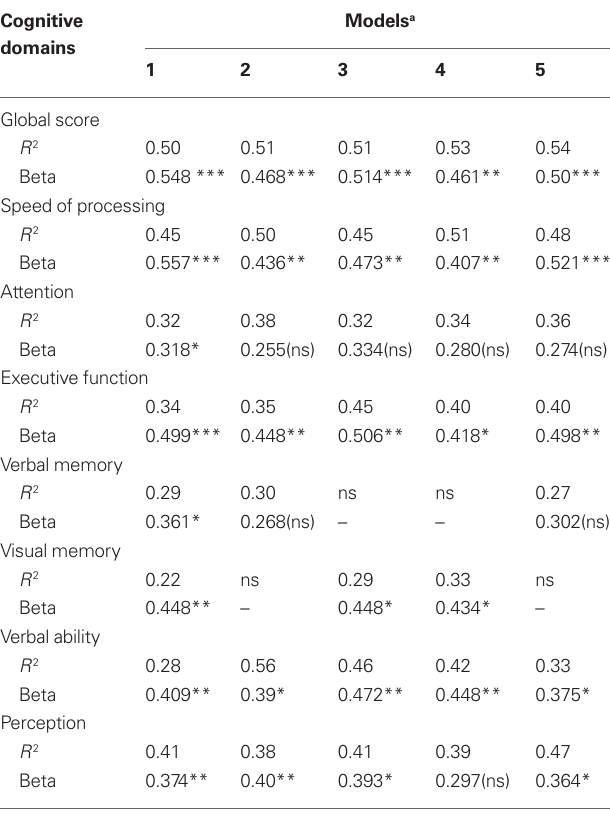
Table A1 | Summary of R 2 and Beta (standardized) for Cognitive activity (number of activities) in final predictive models of neuropsychological